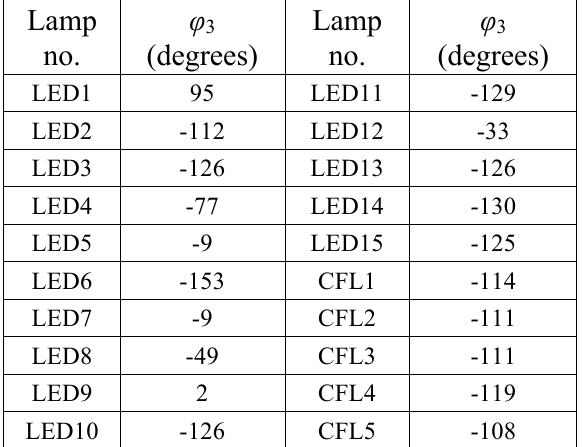
Table 2: Angle of the third–order harmonic current of the lamps used.